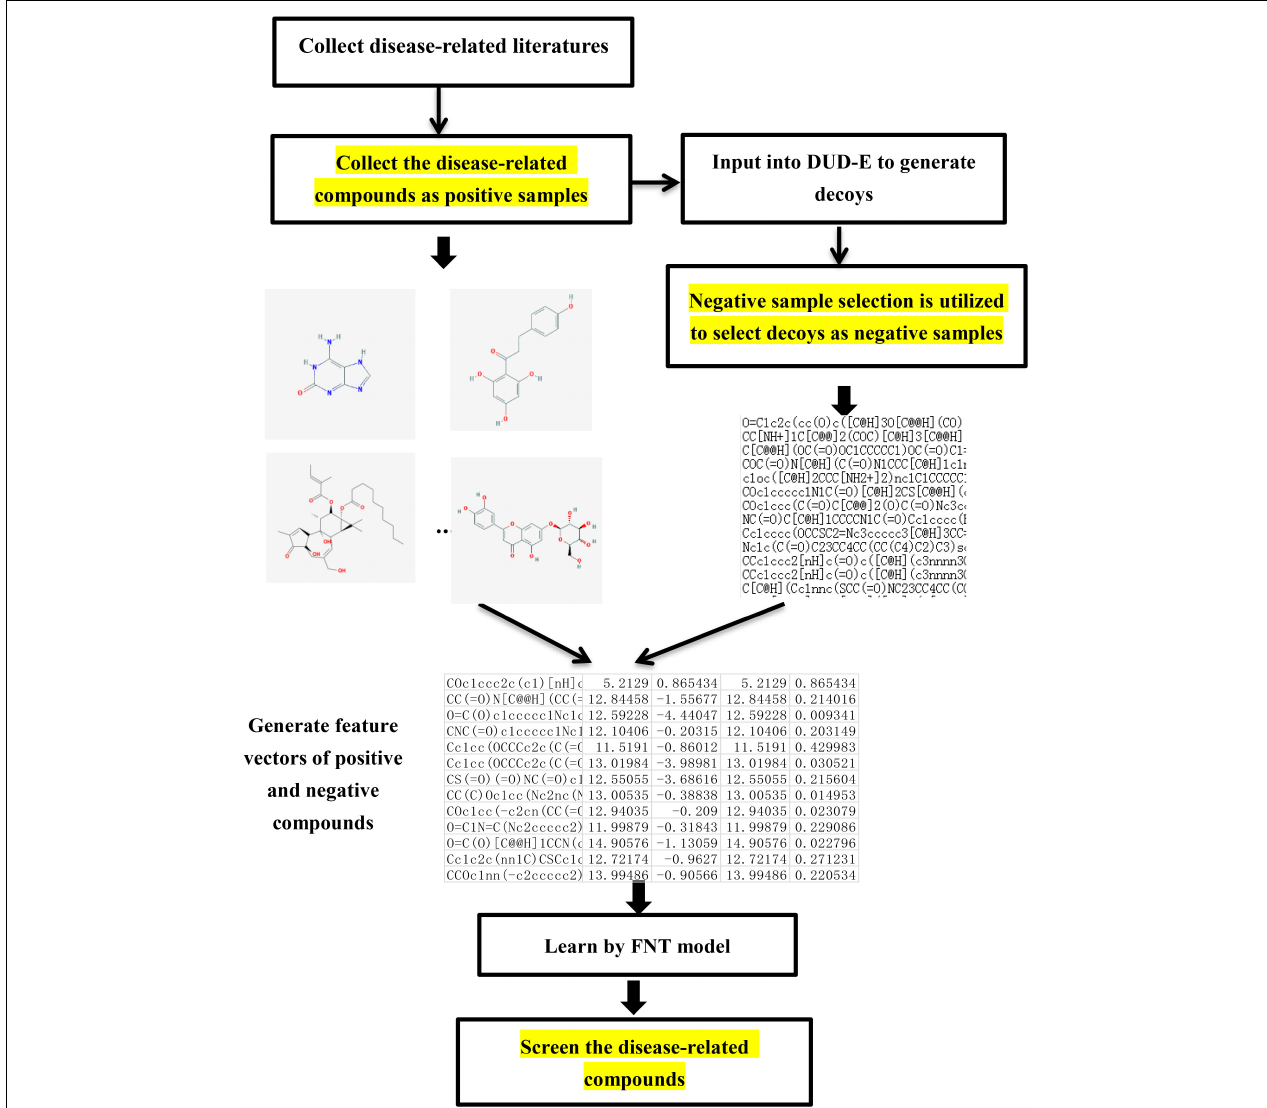
FIGURE 3 | The flowchart of screening disease-related compounds